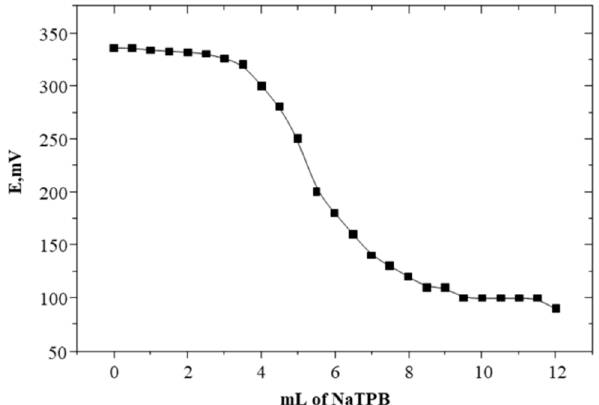
Figure 4. Potentiometric titration of 5.0 mL of 1.0 × 10 − 2 M of SC solution with 1.0 × 10 − 2 M of Na-TPB solution using SC-TPB with PVC plasticized with O -NPOE. Table 3. The precision of the potentiometric titration of 5.0 mL of 1.0 × 10 − 2 M of SC solution with